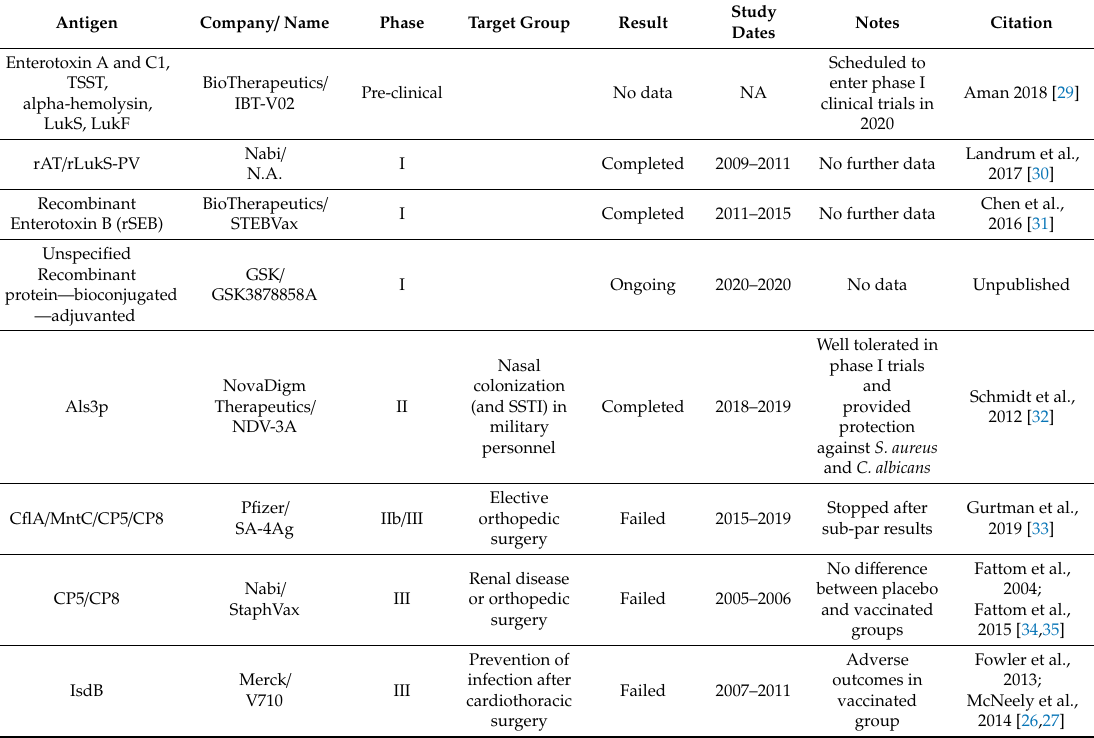
Table 2. Clinical trials of active S. aureus